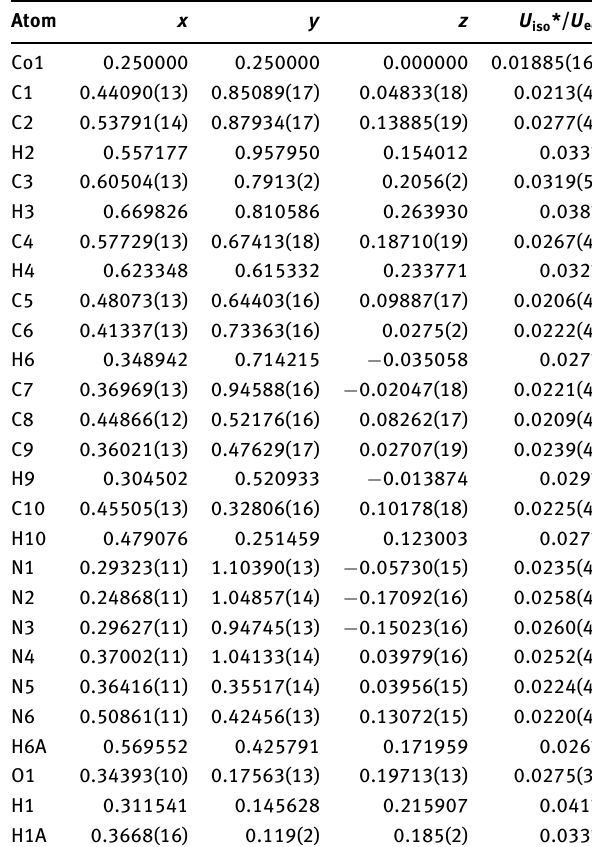
Table 2: Fractional atomic coordinates and isotropic or equivalent isotropic displacement parameters (Å 2